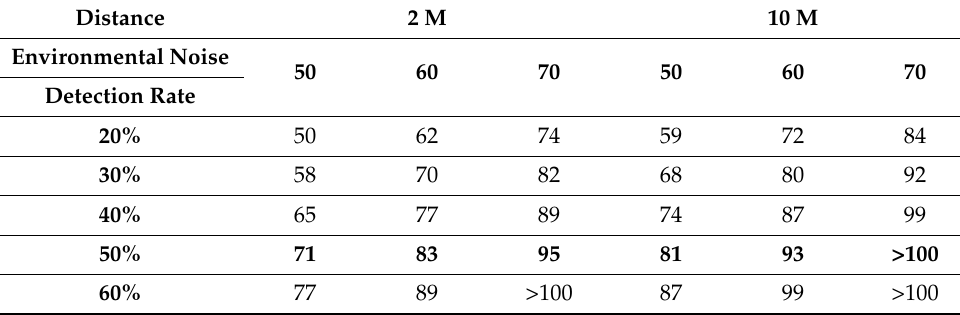
Table 4. Estimated SPL (dBA) of medium-frequency warning